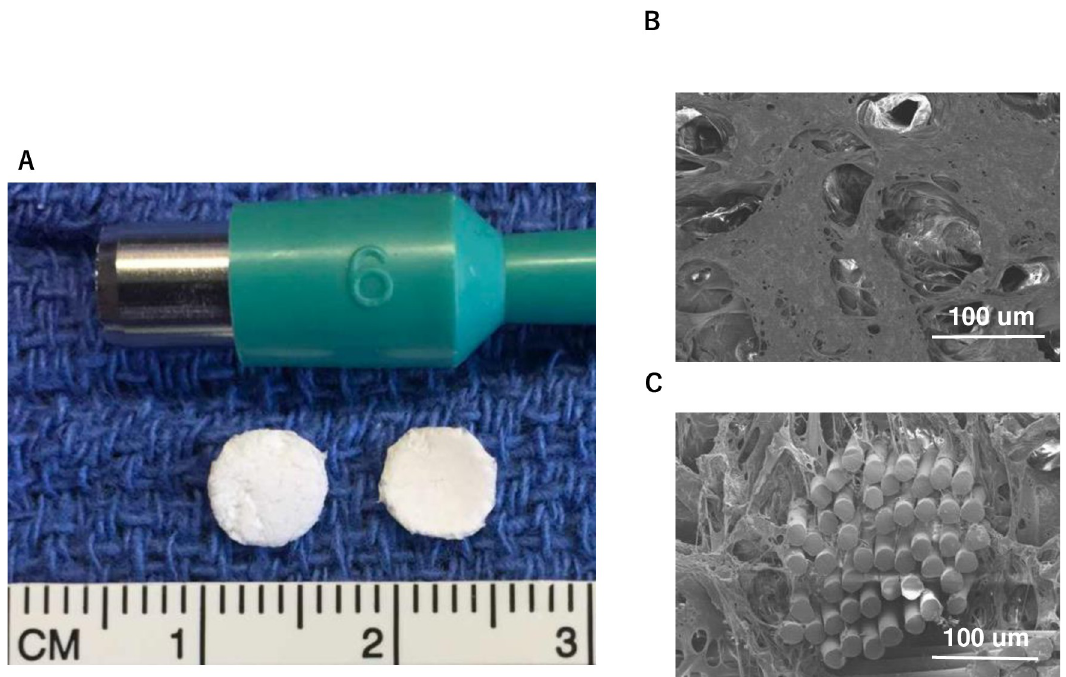
Fig 1. Example of cardiac patch composed of knit mesh of PGA between 2 layers of PLCL ; A: 6-mm diameter biodegradable patch, B: SEM images of the sponge layer 100X magnification. C: SEM images of the sponge layer 500X magnification.This patch consists of a knit mesh of PGA sandwiched between 2 layers of